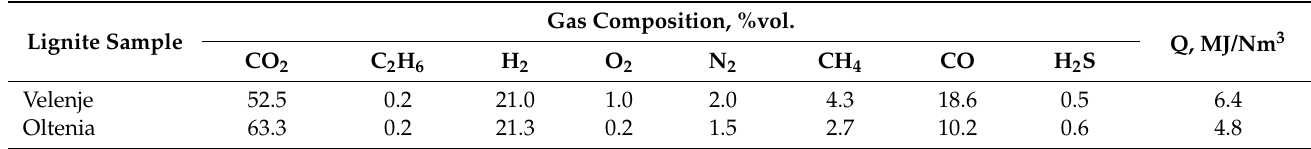
Table 2. Average compositions of gas obtained in the UCG tests.